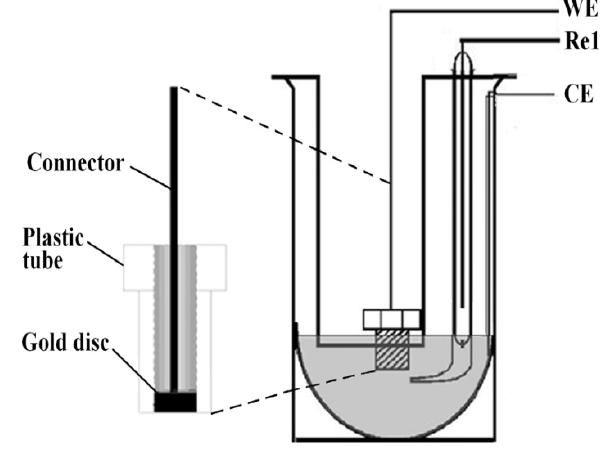
Fig. 1: Tripolar cell (WE: working electrode, Re1: reference electrode and CE: counter electrode).